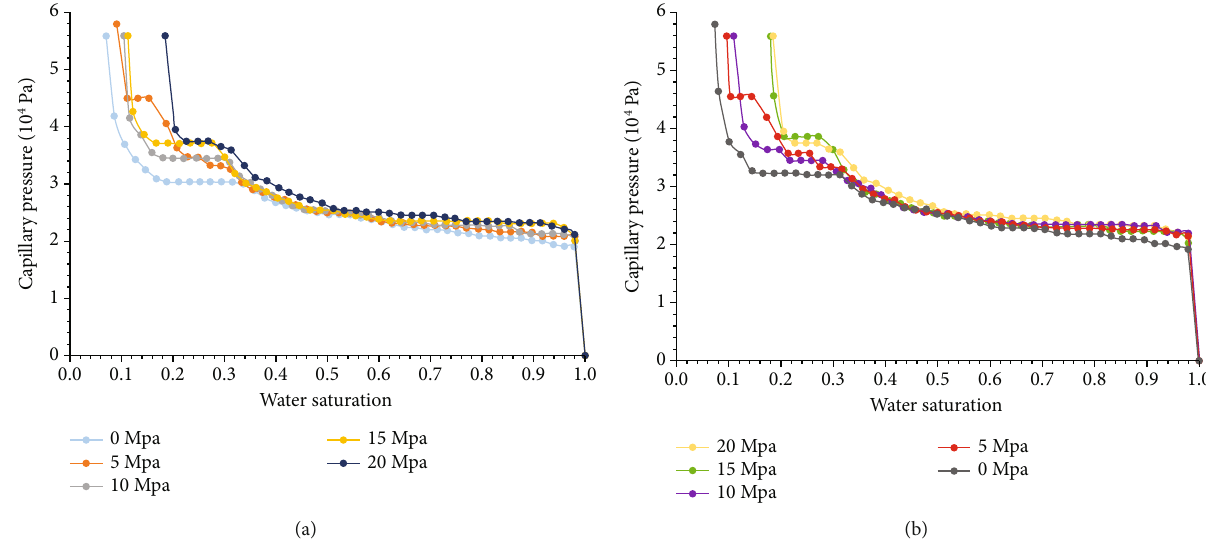
Figure 11: Capillary pressure curves for fractured-porous carbonate rock. (a) Pressurized process and (b) depressurization